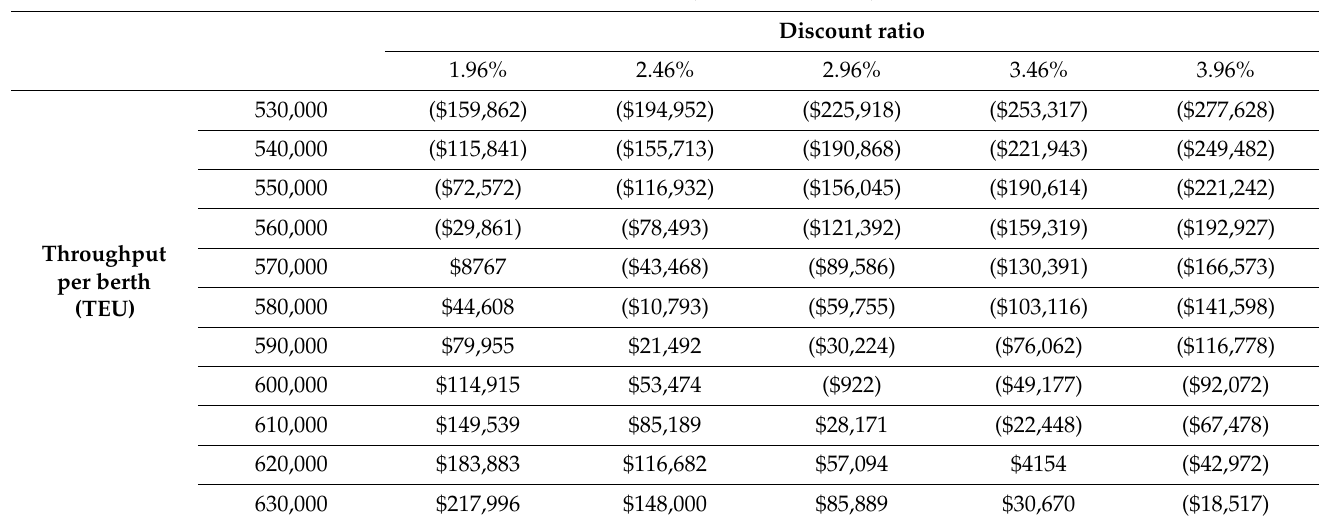
Table A1. Cont. Panel E: 2-berth model (unit: U.S.